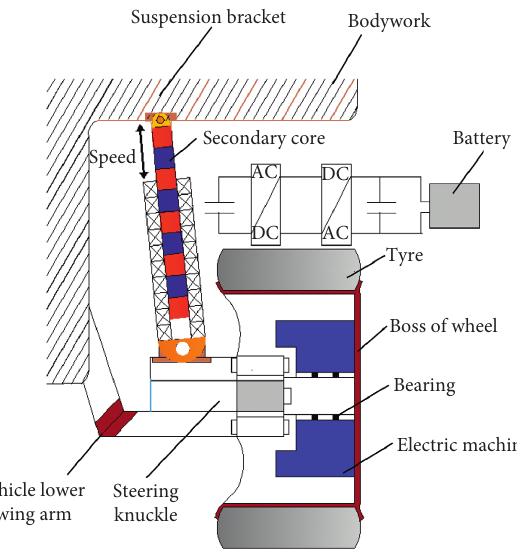
Figure 1: Schematic diagram of electromagnetic actuator on an in- wheel